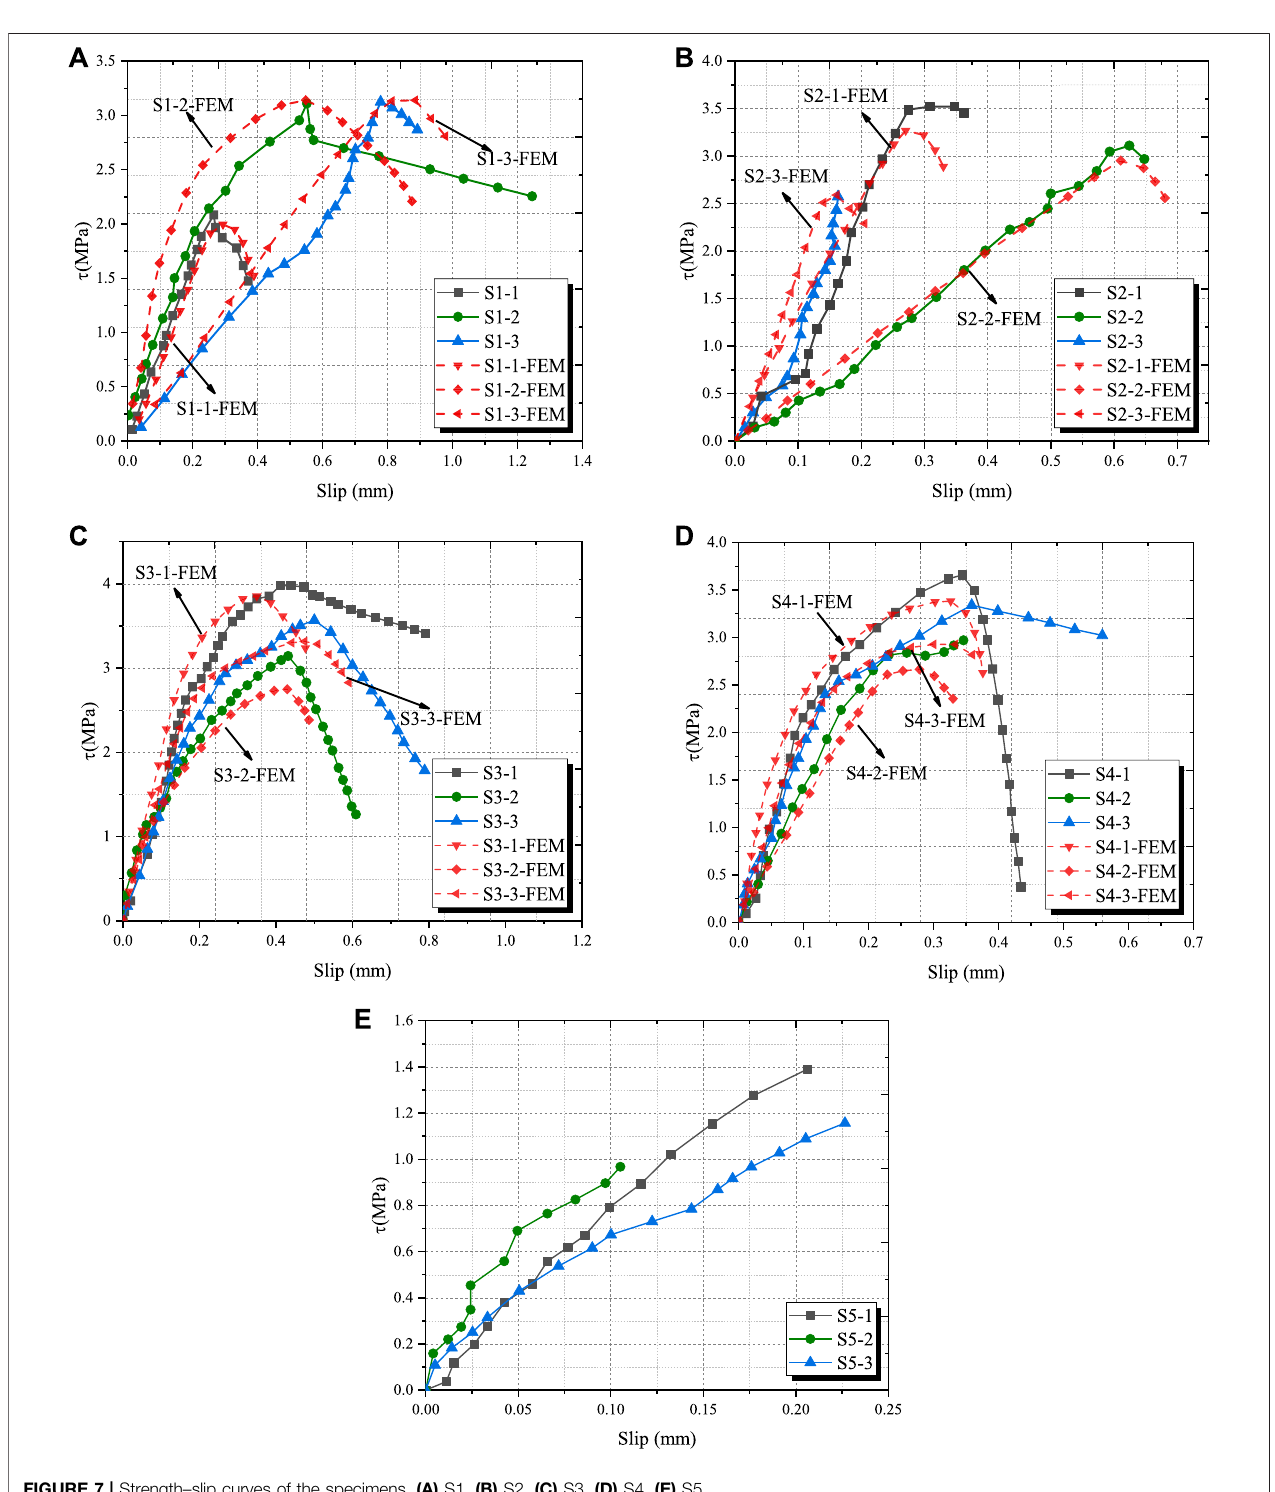
FIGURE 7 | Strength – slip curves of the specimens. (A) S1. (B) S2. (C) S3. (D) S4. (E) S5.